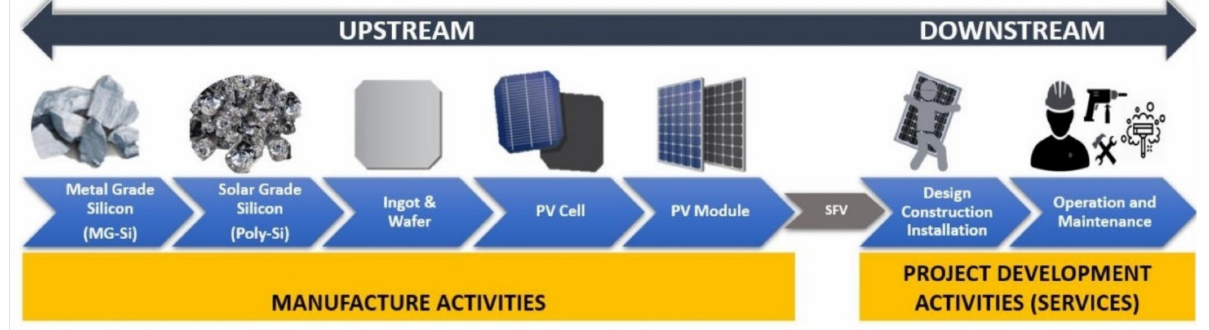
Figure 1. Activities of the PV industry value chain. Source: own